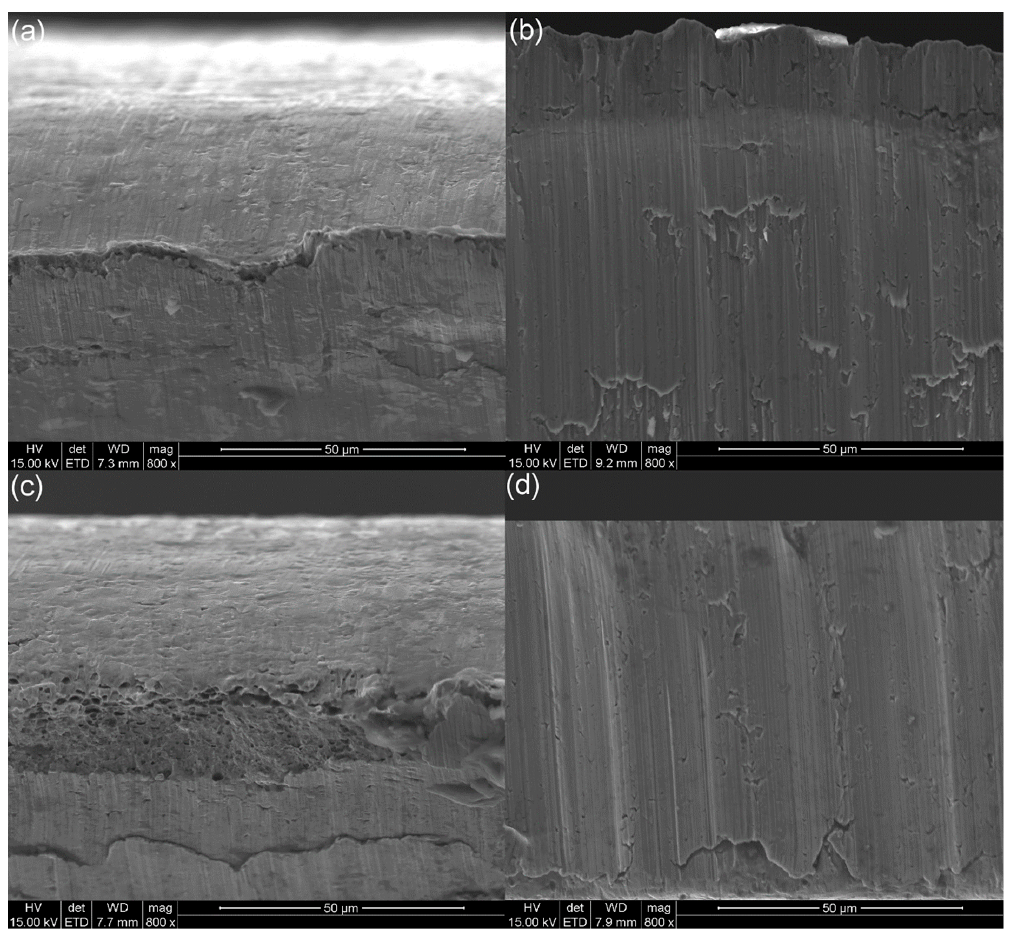
Figure 9. Details of the surface fracture of the steel sheets being cut depending on the localization of the observed surface: top sheet ( a ) and ( b ) and bottom sheet (c ) and ( d ) at the back side of the cutting tool ( a ) and ( c ) and at the front side of the cutting tool ( b ) and ( d ) mag. 800×.